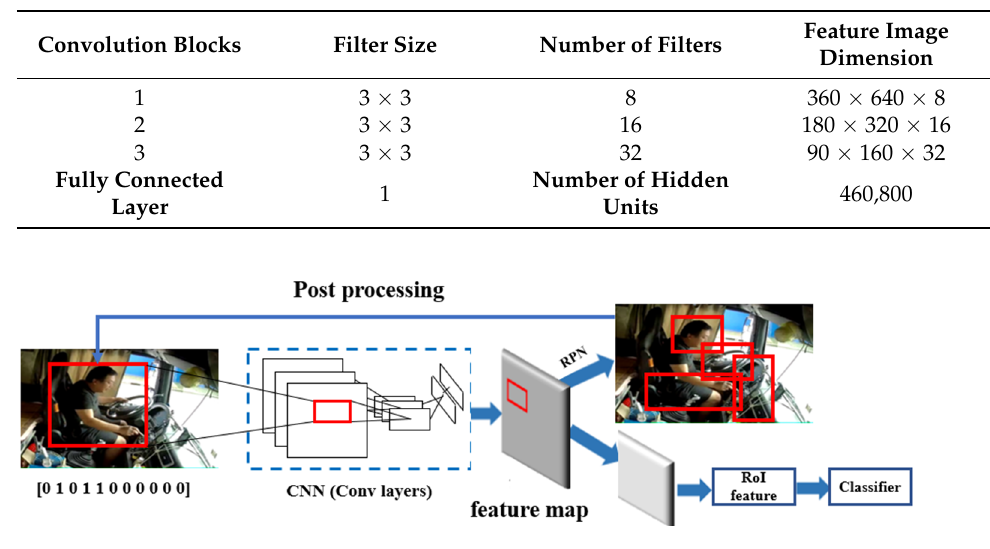
Figure 7. Basic training process of CNN utilized in this